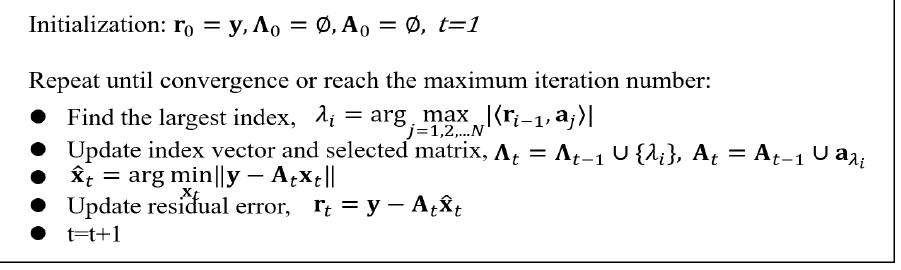
Figure 2. The pseudocode of OMP